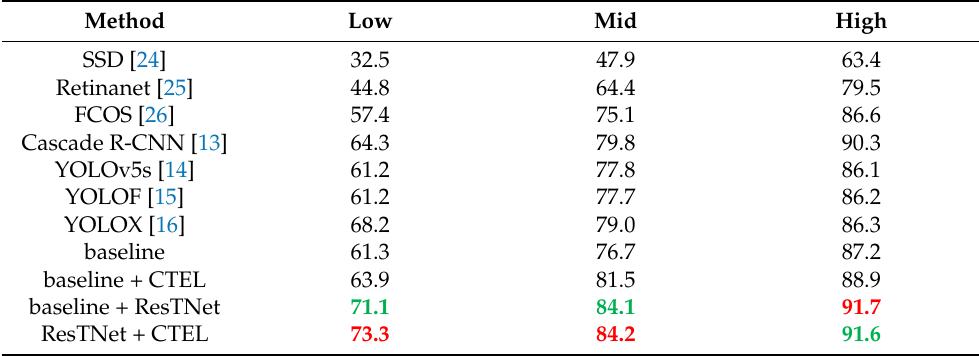
Table 3. The mAP of different comparative samples in some methods are shown in the table. The Top2 in different contrast intervals in the table are highlighted with red and